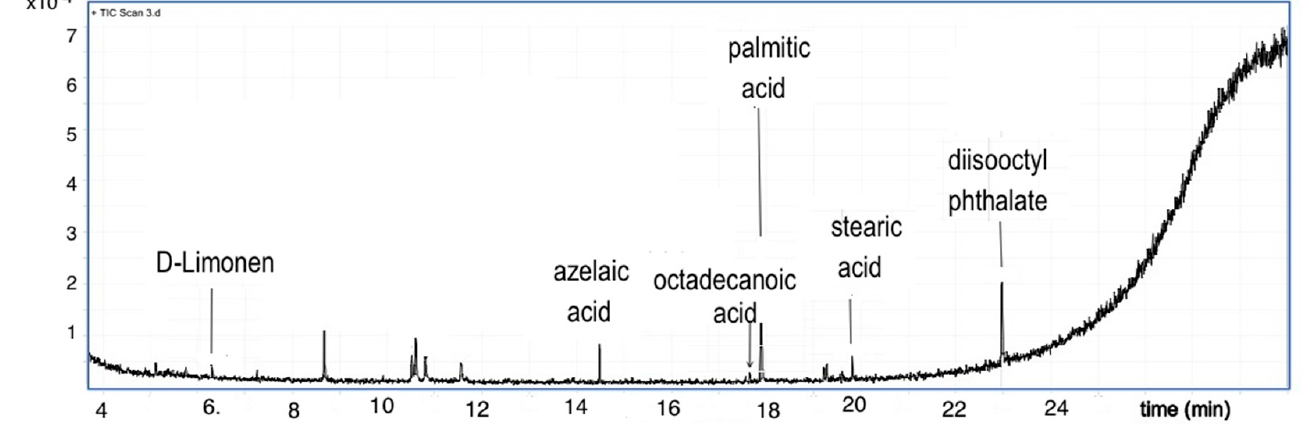
Figure 13. The main components from pictorial layer .